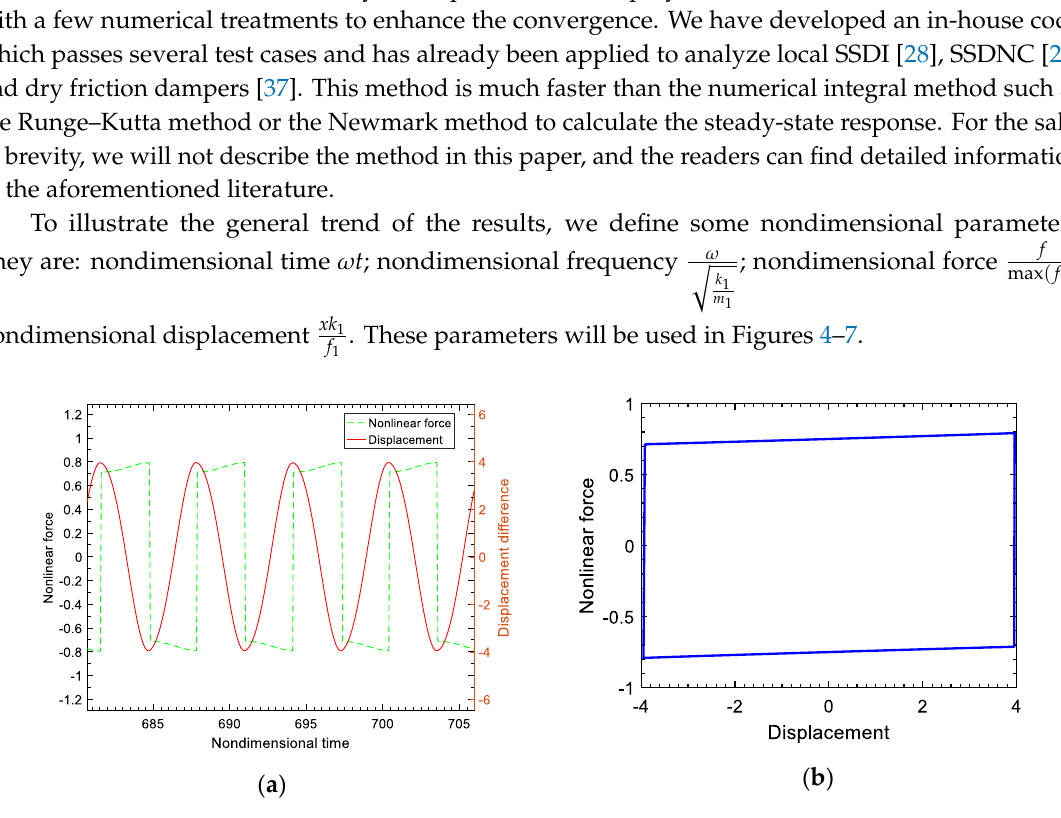
Figure 4. Steady-state response of the nonlinear force of dual-connected SSDI and the relative displacement: ( a ) signal plotted in time domain; ( b ) the force-displacement hysteresis loop.